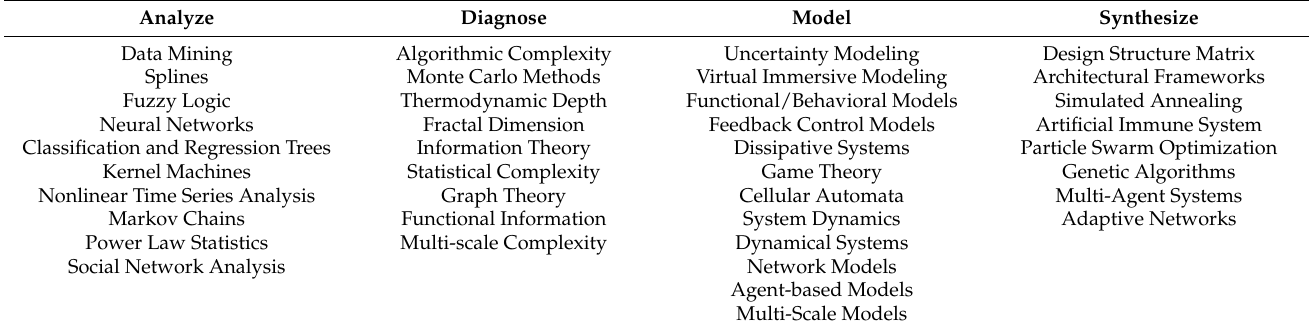
Table 1. Methods Recommended for Systems Engineering to Deal with Complexity [35], p.